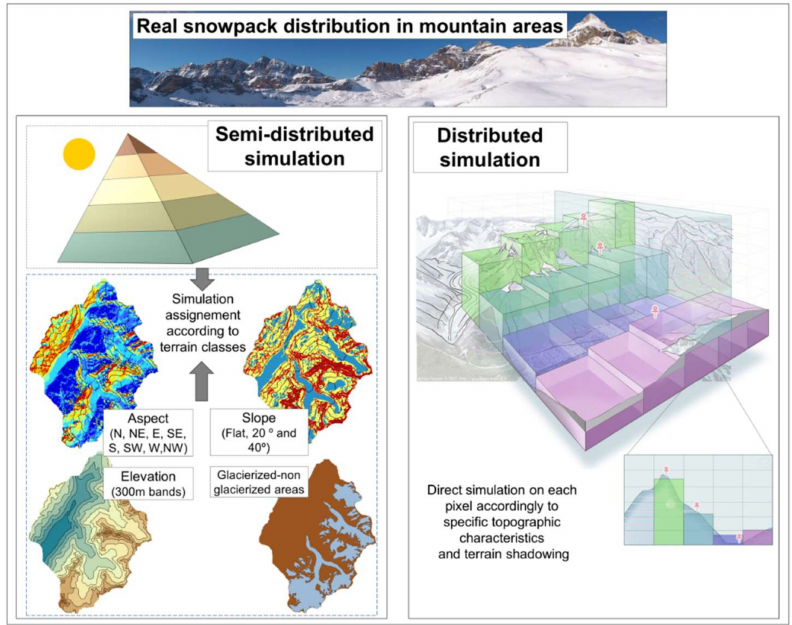
Figure 3. Schematic representation of the approaches used to account for mountain spatial heterogeneity when simulating snowpack